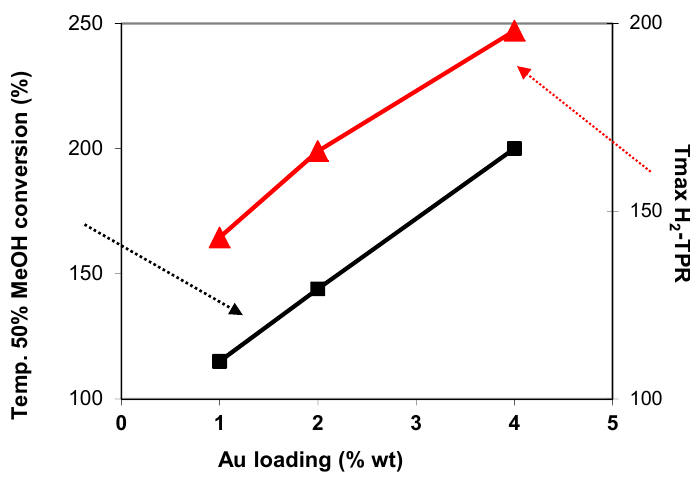
/CeO samples. x 2